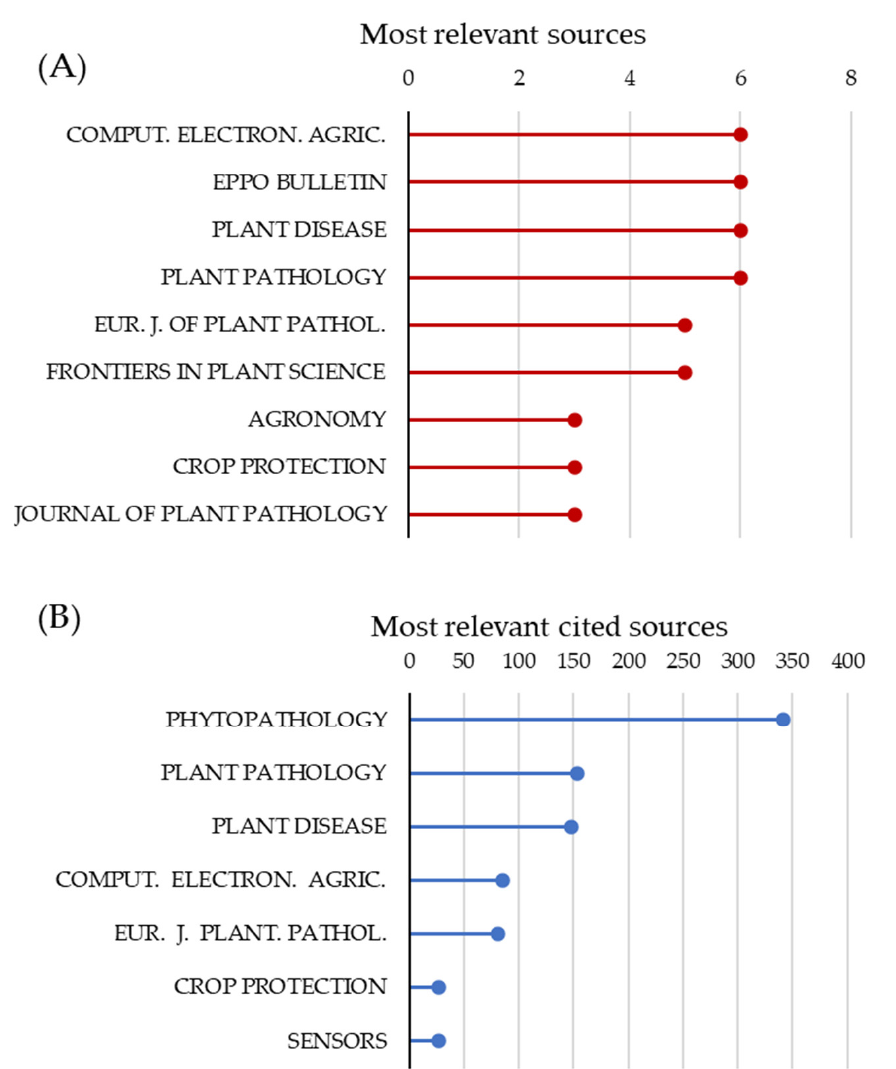
Figure 4. Most relevant sources ( A ) and cited sources ( B ) for the selected documents. To simplify the graphical representation, sources (respectively, most-cited sources) with less than four (resp., 25) documents are omitted.